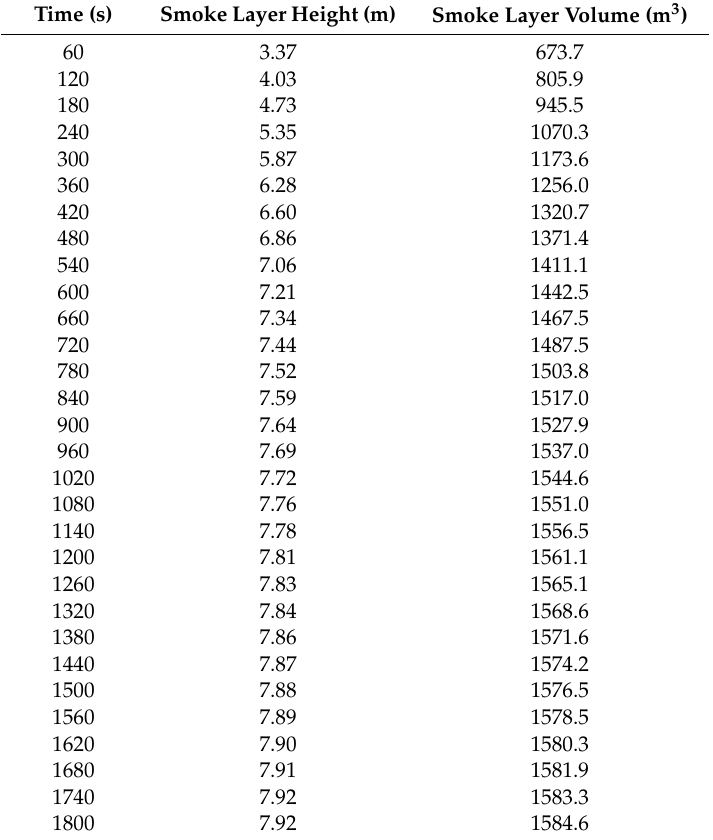
Table 4. Smoke layer height and smoke volume for selected fire scenario.